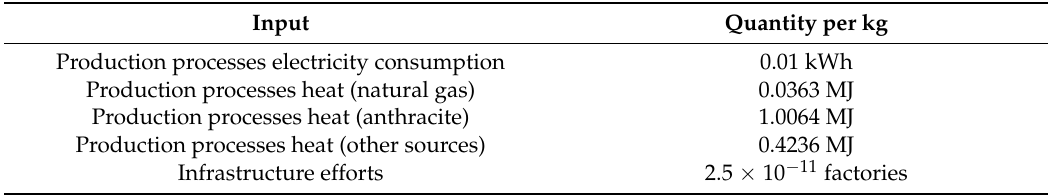
Table 6. Production processes from the EcoInvent inventory for soft ferrites.